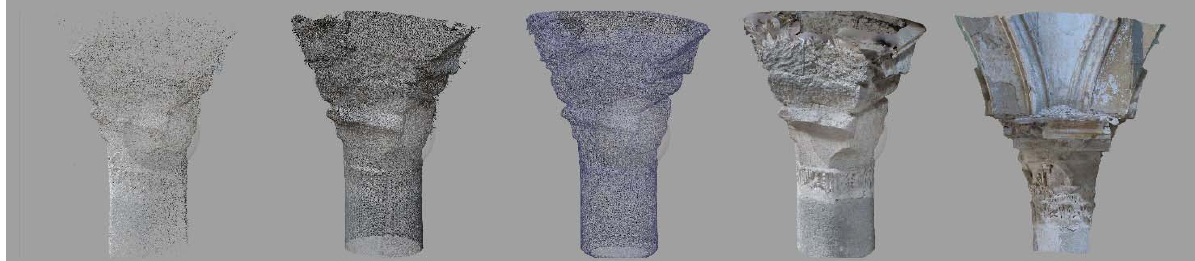
Figure 12. Processing of the photographic datasets of the internal